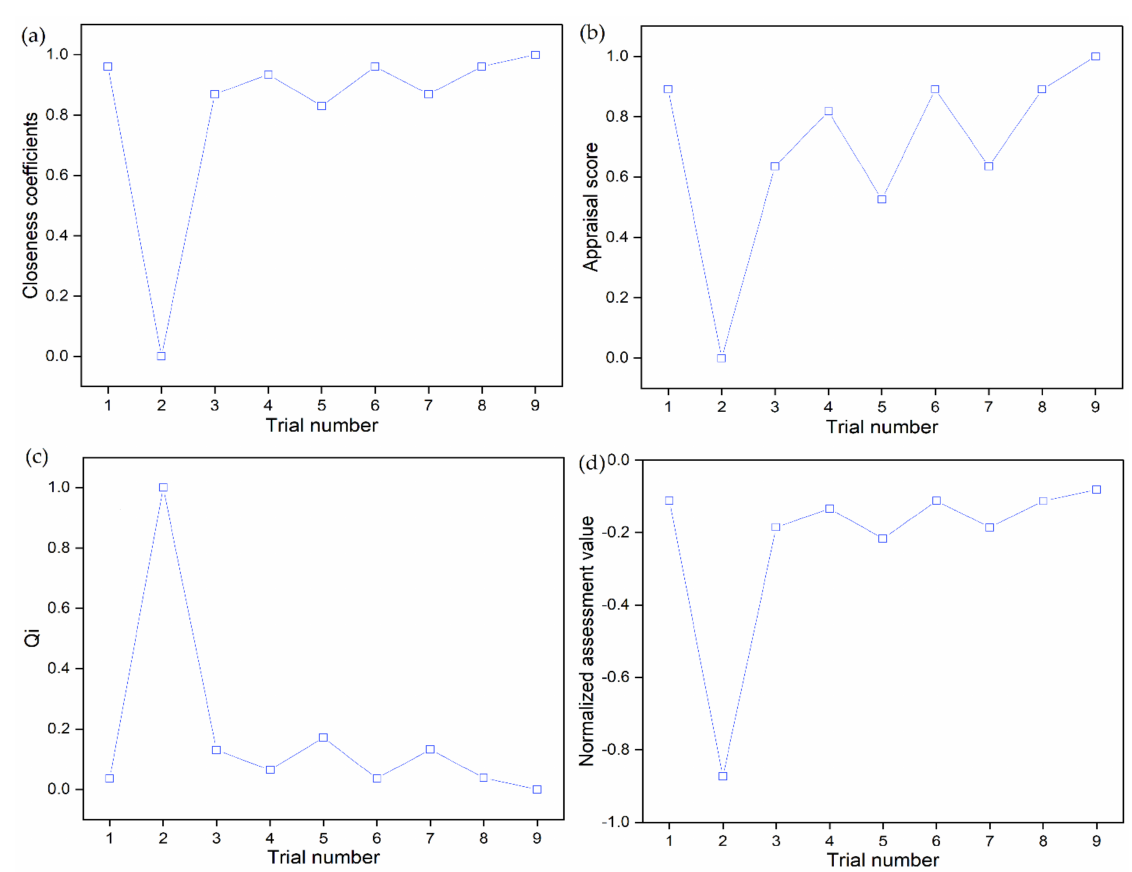
Figure 10. Derived ranking results using MCDM techniques for case study 2 ( a ) closeness coefficients in TOPSIS, ( b ) appraisal scores in EDAS, ( c ) Q i values in VIKOR, and ( d ) normalized assessment values in